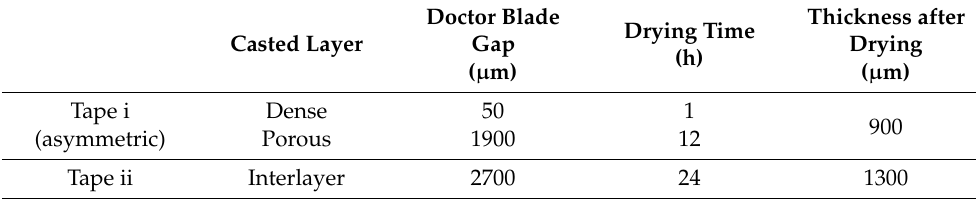
Table 1. Relevant parameters for the manufacturing of the LSCF layers. Doctor Blade Thickness after Drying Time Casted Layer Gap Drying (h) ( µ m) ( µ m) Tape i Dense 50 1 900 (asymmetric) Porous 1900 12 Tape ii Interlayer 2700 24